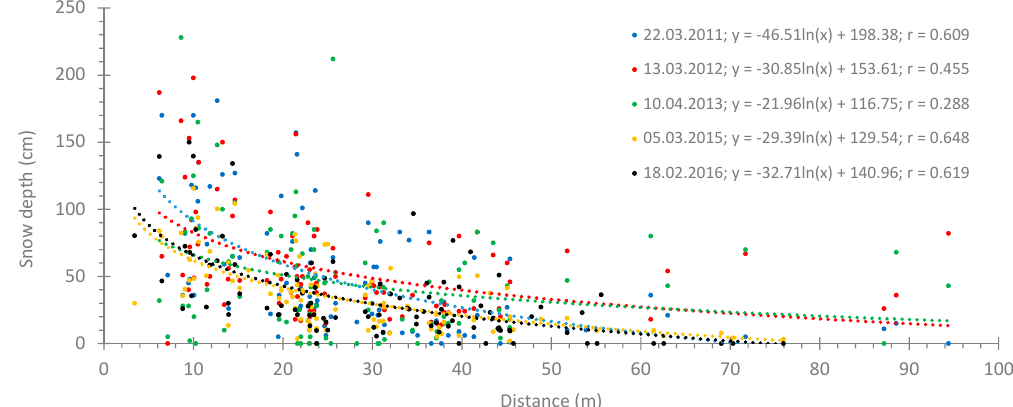
Figure 10. Relationships between the snow depth on the artificially covered ski slope and the closest distance from the snow-making lances at the end of the 2010 − 2011 to 2015 − 2016 seasons. The correlation coefficient “r” measures the strength of the logarithmic relationship. The points represent 96 measured values of the snow depth.